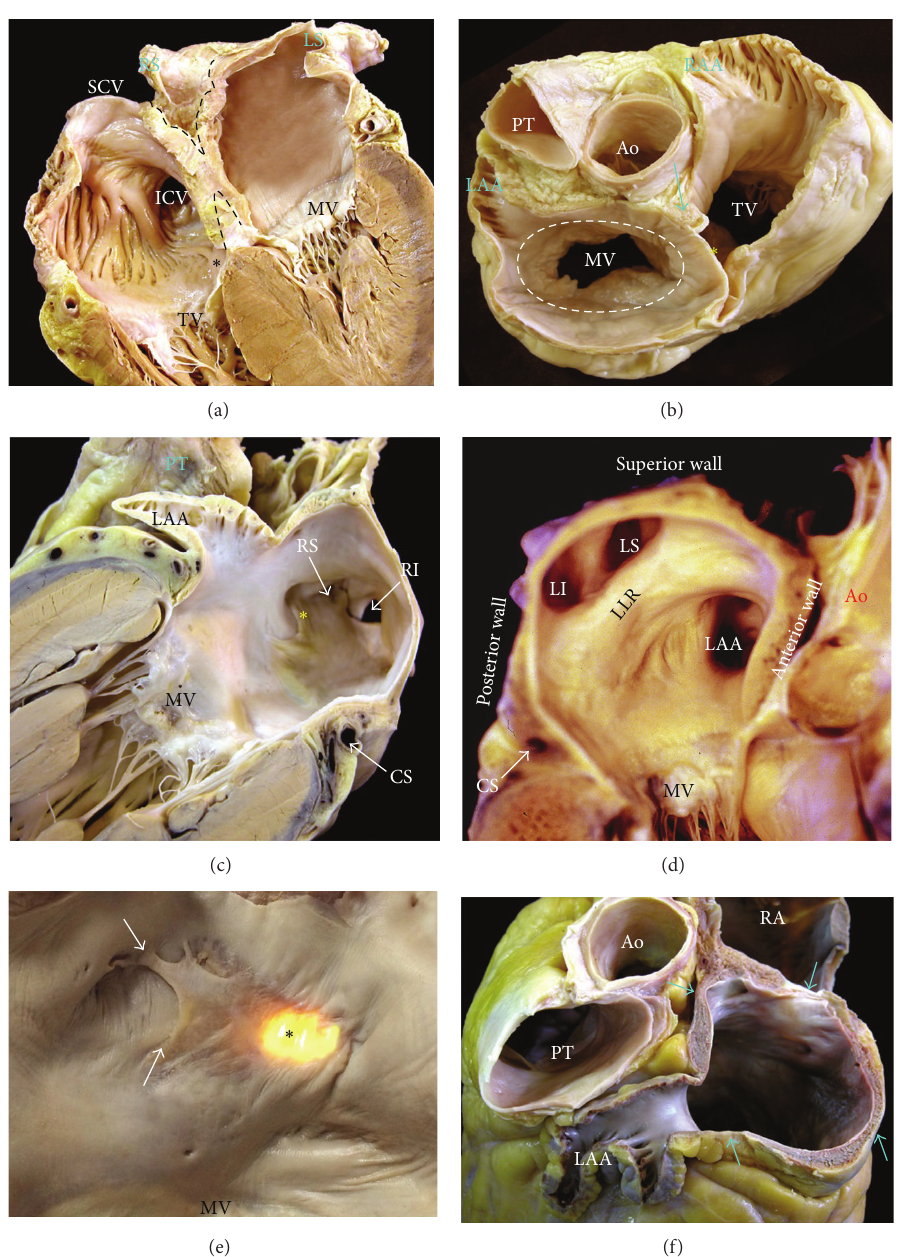
Figure 1: (a) Four-chamber section through the heart showing the offset arrangement of the mitral valve and tricuspid valve which produces the so-called muscular atrioventricular septum ( ∗ ) and the deep infolding of the atrial wall superior and inferior to the floor of the oval fossa (dotted lines). (b) Short axis section across the atrial chamber to show the thin flap valve ( ∗ ) and the muscular rim of the oval fossa (arrow). Note the atrioventricular valves, the vestibule of the left atrium (dotted line), and the different shape and size of the atrial appendages. (c) and (d) Longitudinal sections through the pulmonary venous component showing the orifices of the right and left PVs and the ostium of the left atrial appendage; the flap valve of the oval fossa overlaps ( ∗ ) the rim to form the septal aspect of the left atrium. (e) A magnification of the left aspect of the interatrial septum. Note that, apart from a small crescent-like edge (arrows), the left atrial side of the septum can be seen by transillumination of the oval fossa ( ∗ ) in the right side. In the case of patent foramen oval, the LA can be accessed from the right atrium (RA) through a crevice ( ∗ ) that is the last part of the valve to be sealed to the rim. (f) Short axis section across the left atrial chamber. Note the nonuniform thickness (arrows) of the left atrial wall. MV = mitral valve, TV = tricuspid valve, SCV = superior cava vein, ICV = inferior cava vein, RAA = right atrial appendage, LAA = left atrial appendage, PT = pulmonary trunk, Ao = aorta, LI = left inferior pulmonary vein, LLR = left lateral ridge, LS = left superior pulmonary vein, RI = right inferior pulmonary vein, RS = right superior pulmonary vein, and CS = coronary